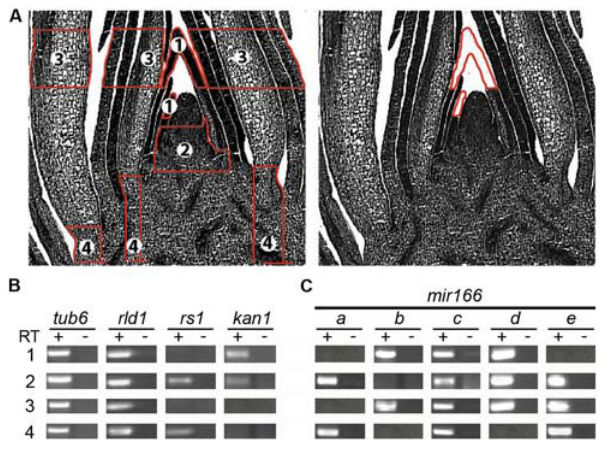
Figure 1. mir166 family members exhibit distinct overlapping expression profiles in the maize shoot apex. (A) Longitudinal sections through a maize apex diagramming regions captured by laser- microdissection (left panel): 1) P2–P3 leaf primordia; 2) the incipient (P0) and P1 leaf primordia plus the base of the SAM; 3) P4–P6 leaf primordia; 4) stem tissue. The right panel shows a longitudinal section of an apex after capturing cells from the P2 and P3 leaf primordia. Note the precision with which cells are captured. (B) Transcript accumulation of